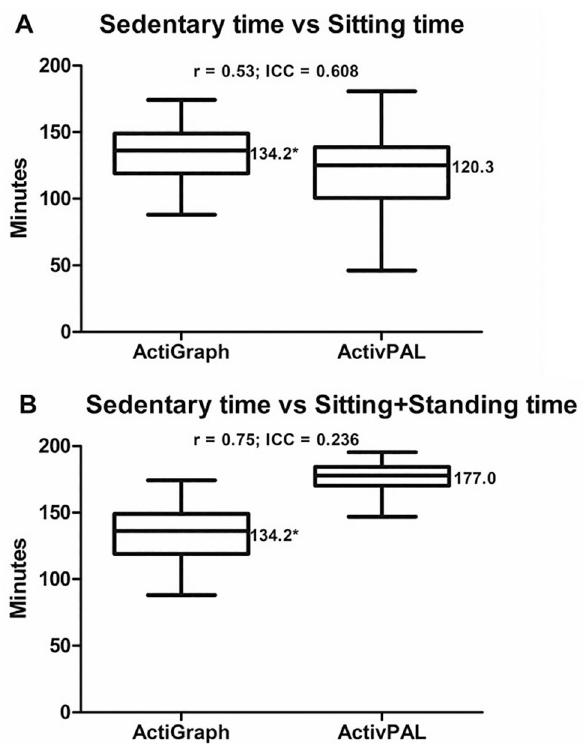
Figure 1 - Correlation and comparison of means in minutes (95%CI) for ActiGraph GT3X and ActivPAL. Detailed legend: A - Sedentary time from ActiGraph GT3X versus Sitting time from ActivPAL. B - Sedentary time from ActiGraph GT3X versus Sitting and Standing time from ActivPAL. Note: r = Pearson's correlation coefficients; ICC = intraclass correlation coefficients; *p < 0.001 for comparison